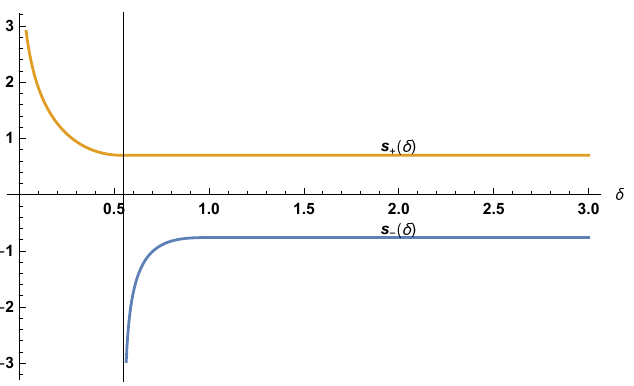
Figure 1 . On this figure we plot the upper (yellow) and lower (blue) bounds s ± ( δ ) on s ( δ, ∆). 3 The vertical line is δ = δ gap = , below which we do not have a lower bound. The divergence of π s + ( δ ) at δ = 0 is spurious and is cancelled by log δ in q